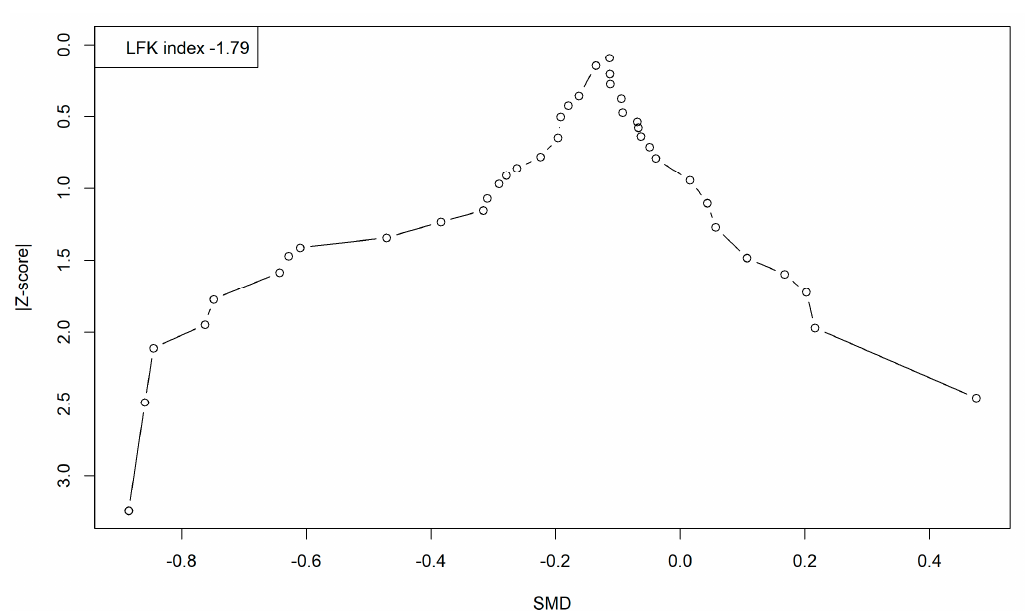
Doi plot and LFK index of the studies included in the sensitivity analysis